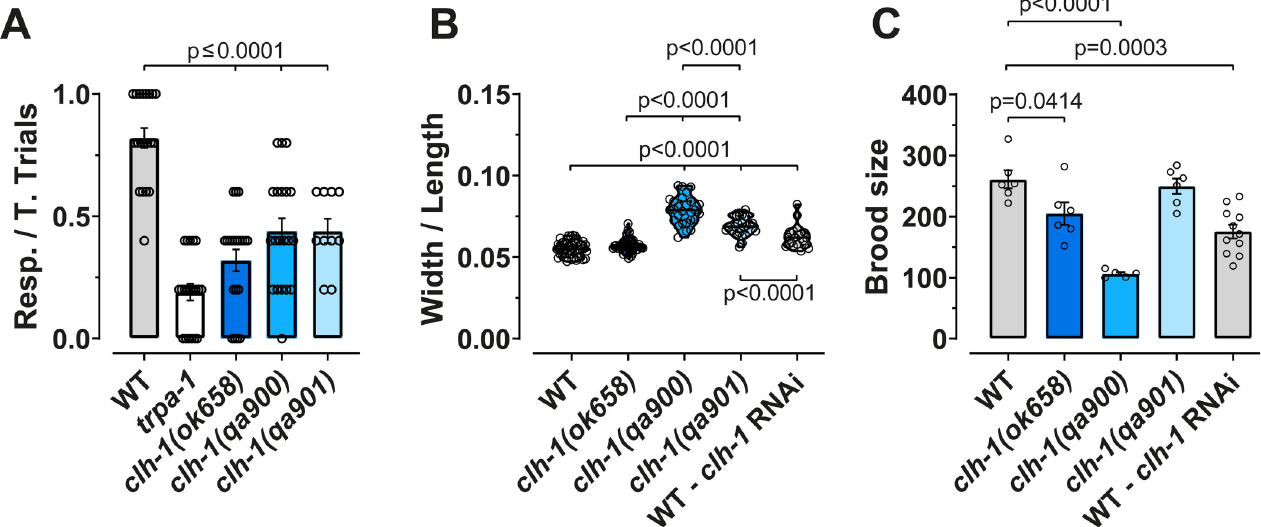
Fig 2. Variable phenotypic compensation in the three clh-1 mutants. (A) Nose touch responses in the three clh-1 mutants; wild type and trpa-1 worms were used as positive and negative controls respectively [27,31]. Data are expressed as individual animals (open circles) and as mean ± SEM, n = 20 except qa901 that was 10. (B) Body size ratios (width/length) of WT, clh-1 mutants, and clh-1 RNAi. The length of the worms was determined by measuring the distance between the tip of the nose and the end of the tail in anaesthetized animals laying straight on agarose pads. The width was determined by measuring the distance between the vulva opening and the back of the worm. Data are expressed as individual data points (open circles) and as violin plots (n = 44, 45, 27, 25, and 20 respectively). (C) Brood size of WT, clh-1 mutants, and clh-1 RNAi. The columns represent the average brood size of each genotype, and the open circles represent individual worms (n = 6, 6, 5, 6, and 11 respectively). Data represent mean ± SEM and were obtained by counting the number of adults found in plates where individual worms were grown for 24 hours over 5 consecutive days. Statistical analysis was by one-way ANOVA followed by Tukey’s. Statistical differences are shown in the graphs as p values. Data used for this figure are reported in the S1